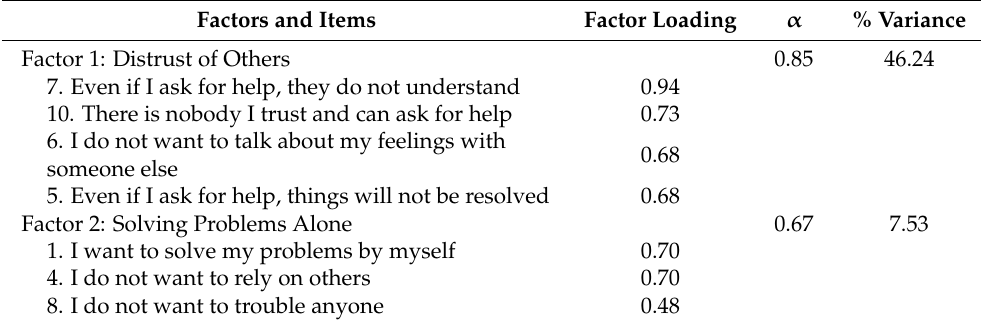
Table 3. Results of the Factor Analysis for the Barriers to Help-Seeking Scale (Principal Factor Method, Promax rotation). Factors and Items Factor Loading α % Variance